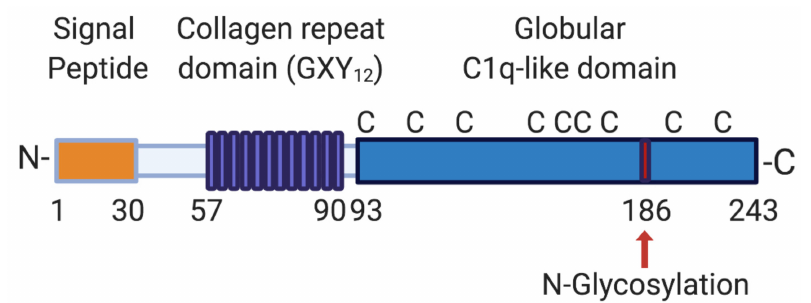
Figure 1. Domain structure of human CTHRC1. The longest CTHRC1 variant encodes a 243 amino acid protein with a 30 amino acid cleavable signal sequence, followed by a short collagen repeat domain consisting of 12 GXY repeats (where G stands for glycine, X for any amino acid and Y for tyrosine). CTHRC1 also contains a globular cysteine-rich (C indicates the positions of